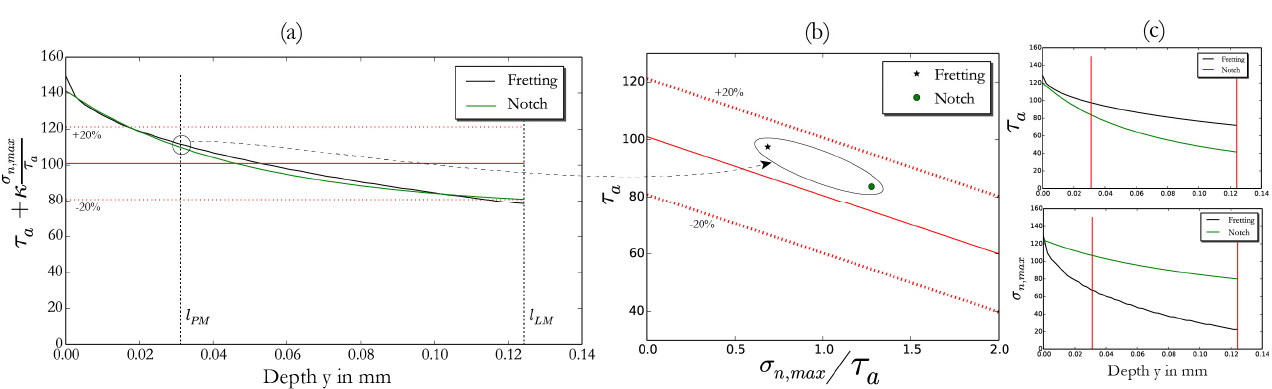
Figure 2: (a) Variation of the multiaxial fatigue index against distance in the specimen (from the hot spot) for the fretting fatigue test and for the optimized notch configuration. (b) Points representing the shear stress amplitude,   , for both configurations. (c) Variation of / stress, , n max a